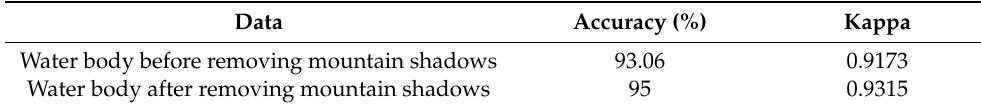
Figure 10. The results of removing mountain shadows in the selected region. ( a ) Landsat 8 image, ( b ) ground truth, ( c ) water body results. Table 5. Accuracy evaluation after removing mountain shadows.